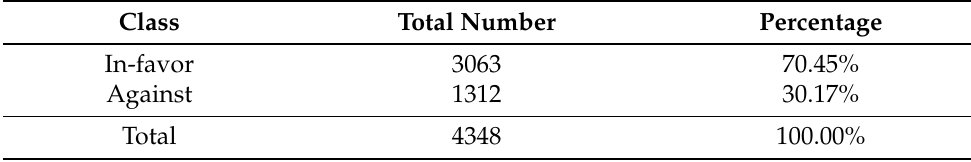
Table 4. Statistics for the manually annotated dataset.